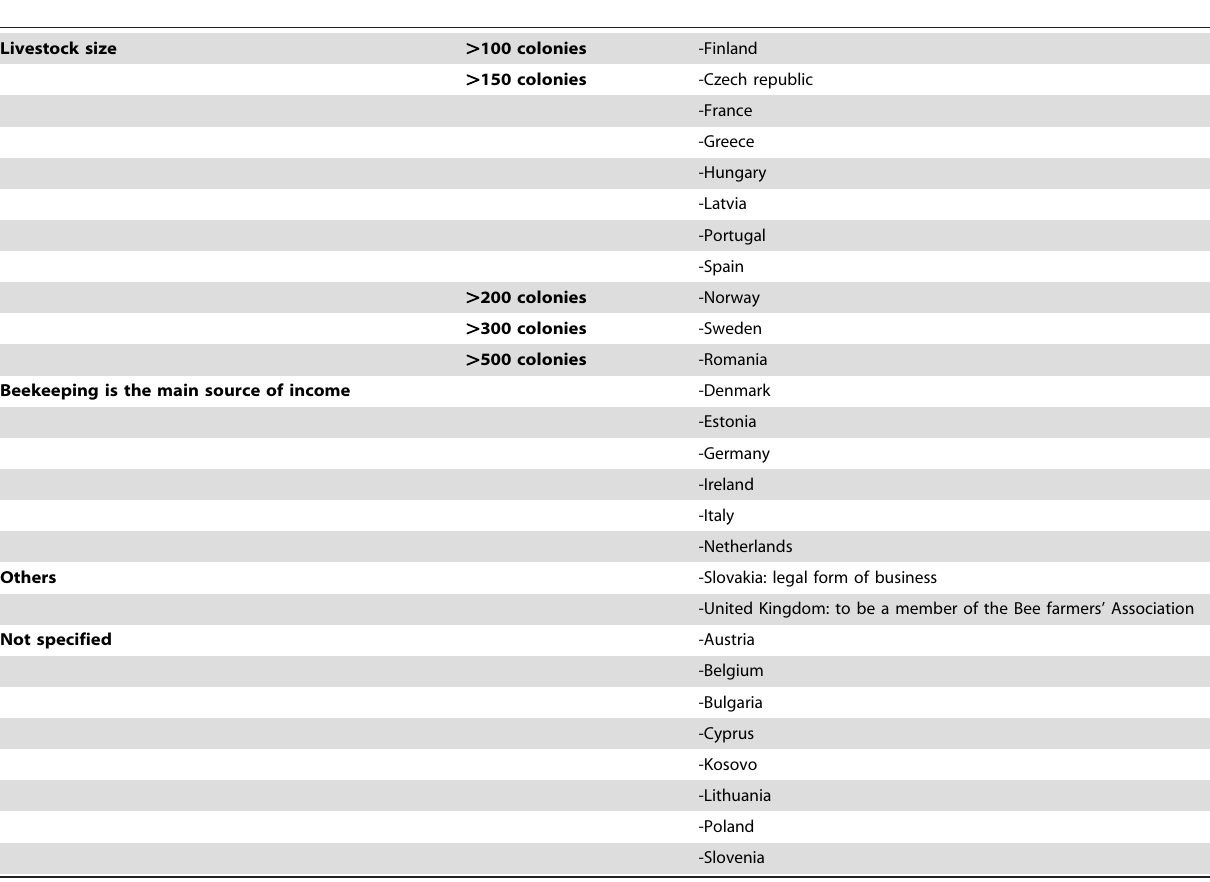
Table 3. Definition of professional beekeeper according to the different countries in Europe in 2010.